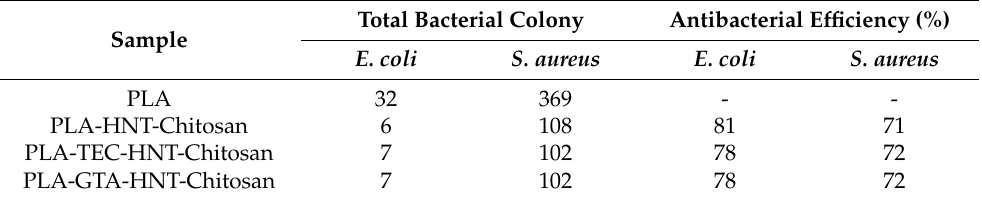
Figure 10. Antibacterial activity of various films of PLA and PLA containing 0.5%, 1%, and 2% of chitosan against ( a ) Escherichia coli ; ( b ) Staphylococcus aureus ; ( c ) Pseudomonas fluorescens ; and ( d ) Vibrio parahaemolyticus . a–c values indicate significant differences at p < 0.05. Ref. [106], published by MDPI, 2021. Table 12. Antibacterial efficiency against E. coli and S. aureus . Ref. [64], published by Elsevier,